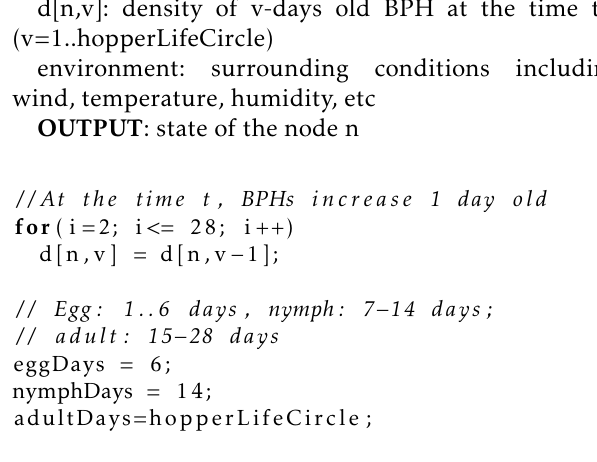
ALGORITHM : Transition rule (behaviors) of node